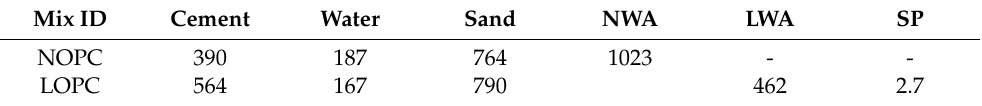
Table 3. Mixture proportions of the ordinary Portland cements (OPCs) (kg/m 3 ).